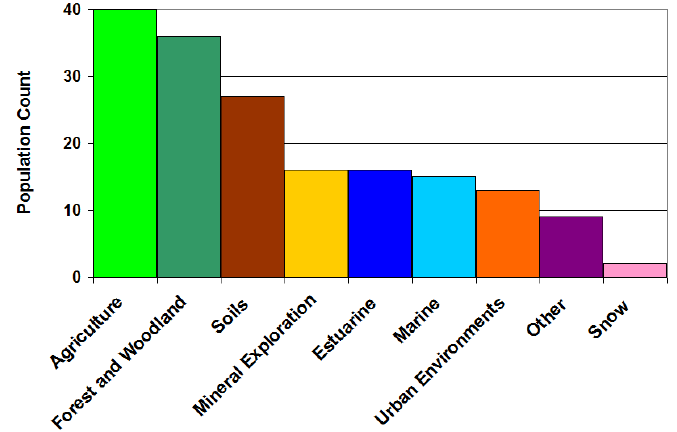
Figure 1. Areas of expertise self-nominated by survey respondents ( n =